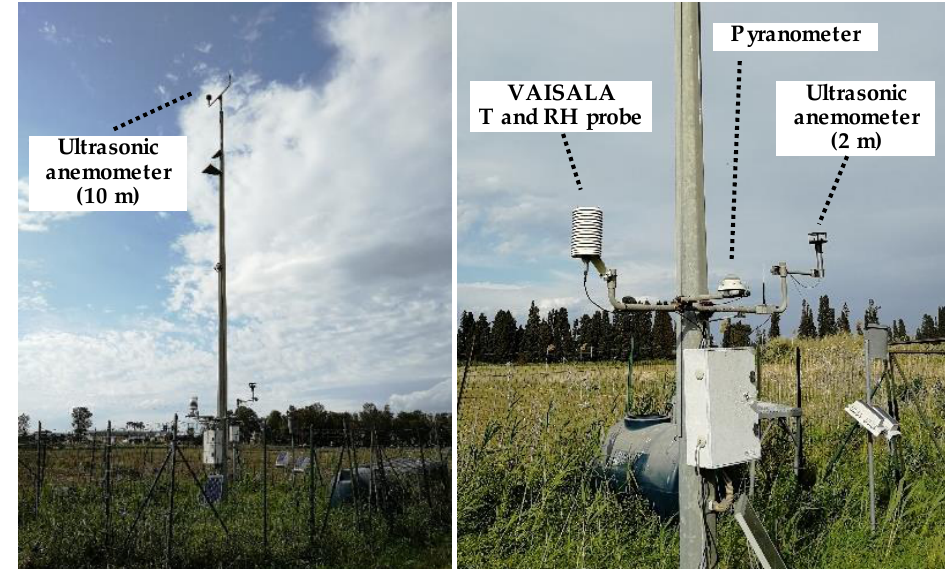
Figure 4. Picture of the Sicilian Agrometeorological information system (SIAS) weather station and its probes.